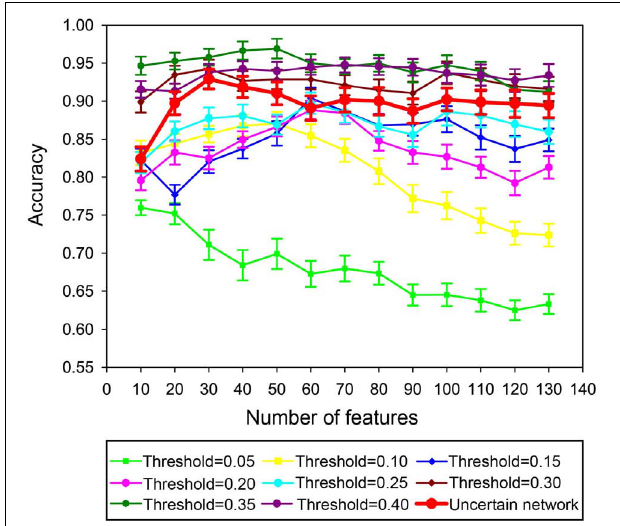
FIGURE 6 | Classification performance using the thresholding method to map discriminative subgraph features of the uncertain brain network to the certain network. The ordinate denotes the accuracy, and the abscissa indicates different feature numbers.